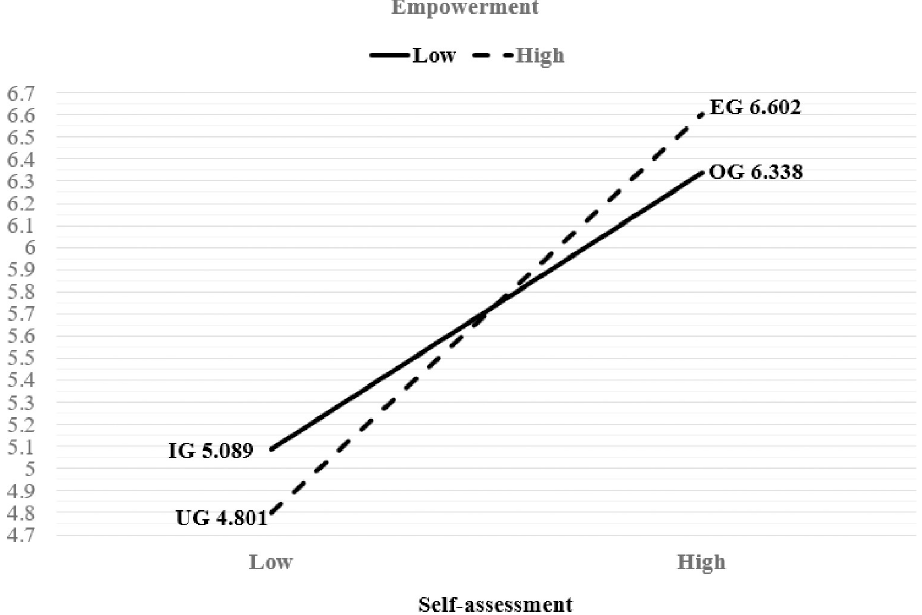
Fig 2. Effects of empowerment and self-assessment on information search behavior.